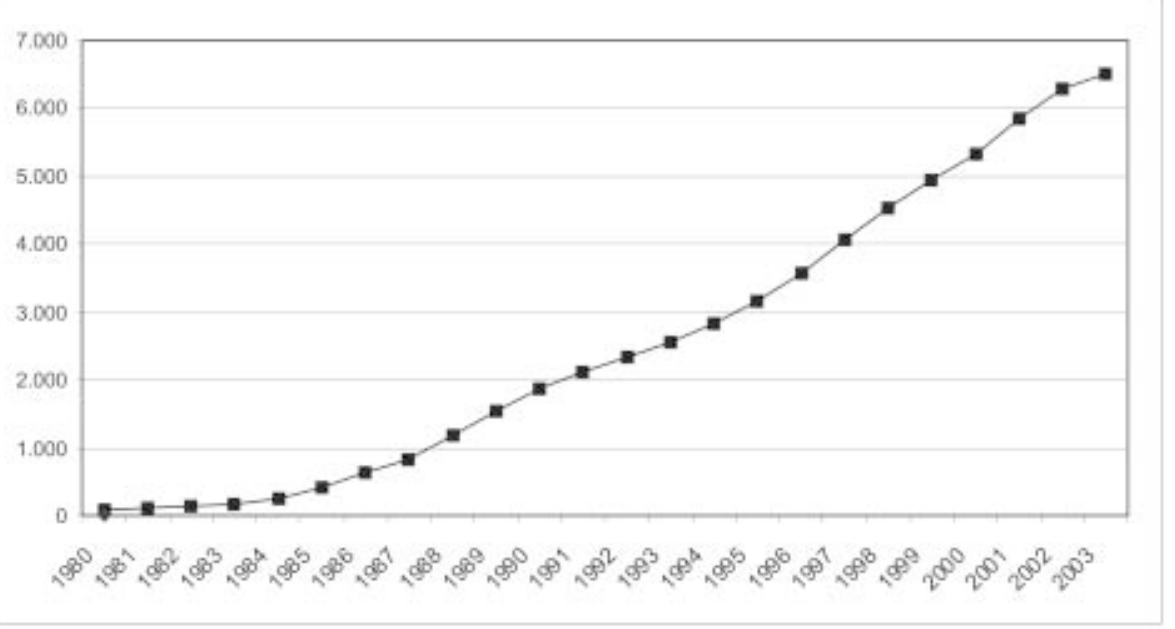
Fig 2. Total number of foreign capital firms in Turkey,